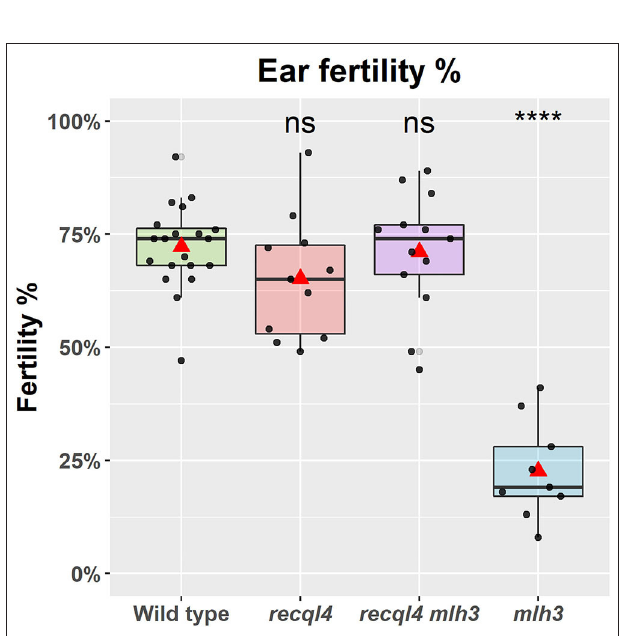
FIGURE 2 | Fertility of the selected F 2 plants as a percentage of fertile florets per ear (%). The statistical comparison with the wild type (WT) was done with the t -test where “ns” is not significant, **** p < 0.0001. The red triangle shows the mean per genotype. Each dot in the graph represents the average three ears of one